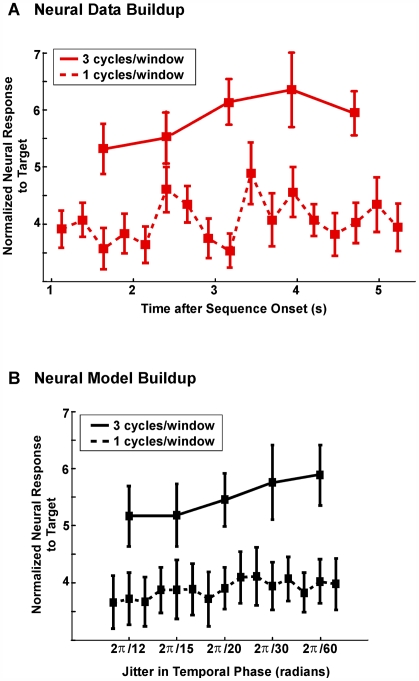
Analysis of neural buildup over time in target task for different duration windows, both for data and in a model of the data.(A) Normalized neural response to target rhythm as a function of time, in target task, averaged over participants. The solid curve is identical to the red curve in Figure 5. The dashed curve is the result of identical analysis except that the normalized neural response is calculated for every 250-ms cycle of the target rhythm, rather than over the 750-ms window of three-cycles used above. Only the longer window shows buildup, implying that it is not power per cycle that is growing, but phase coherence over several cycles. Error bars represent standard error over all participants. (B) Model results for 750 ms (three cycles) windows, solid curve, and for 250 ms (one cycle) windows, dashed curve. The modeled normalized neural response rises as temporal phase jitter decreases, but only in the three-cycle case, since the power per cycle is constant but the temporal phase coherence across cycles increases. Error bars represent standard deviation over 30 simulation runs.